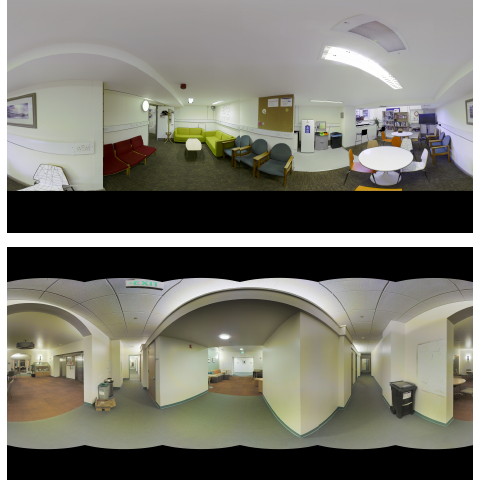
Figure 5. Original panoramic images: Internal TLS capture (top) and 2D3DS panoramic RGB sample (bottom) Table 1. Comparison of our proposed method using partial